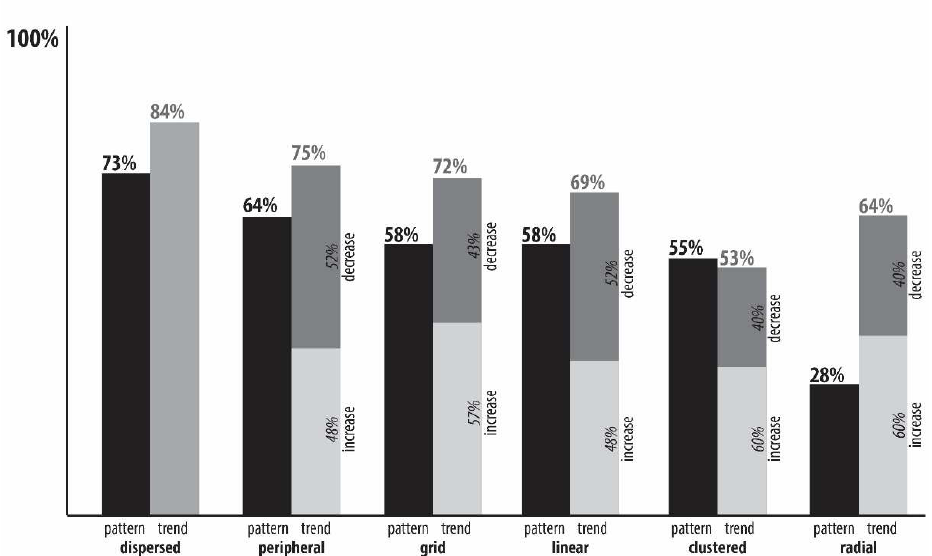
Figure 4. Results of spatial pattern and temporal trend recognition effectiveness calculated as a percentage of participants’ correct